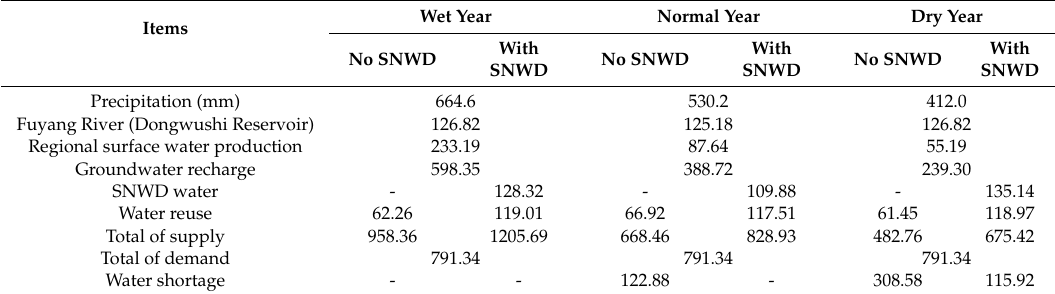
Table 1. Water supply and demand in di ff erent level year (unit 10 6 m 3